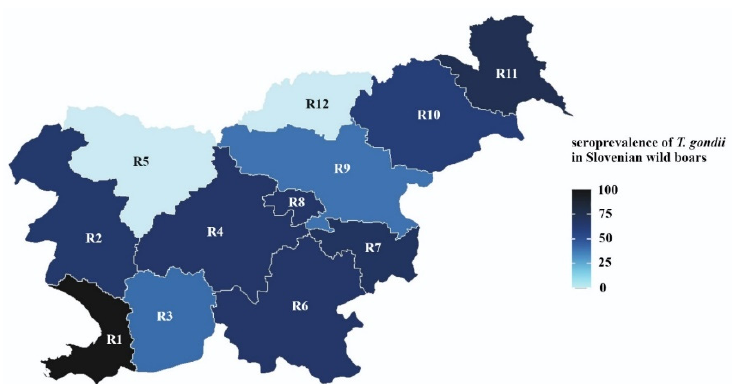
Figure 1. Seroprevalence of T. gondii in Slovenian wild boar (%). Regions (R):